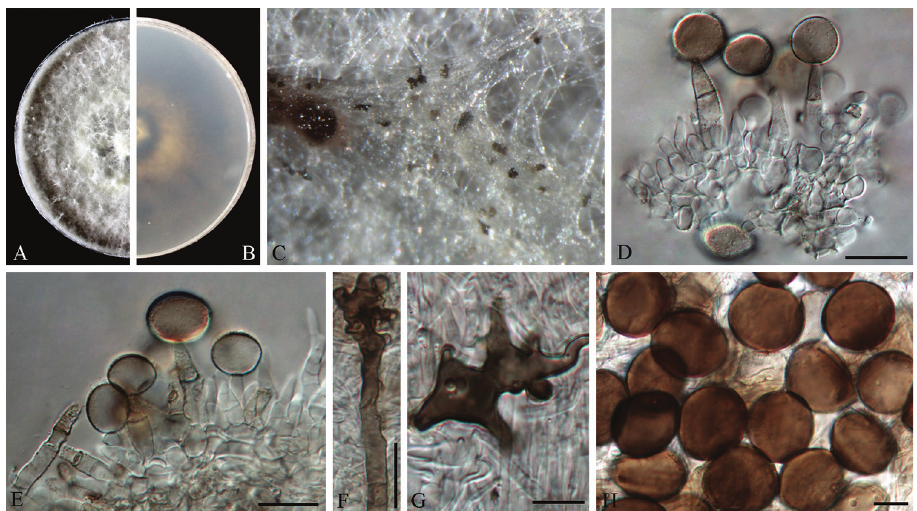
Figure 9. Arthrinium pseudoparenchymaticum (from ex-holotype strain CGMCC 3.18336) A–B 8 d old cultures on PDA C Colony on MEA producing conidia masses D–E Conidiogenous cells giving rise to conidia F–G Dentate conidia H Globose conidia. Scale bars = 10 µm. Arthrinium subroseum M. Wang & L. Cai, sp. nov. MycoBank: MB824913 Figure 10 Type. CHINA, Jiangxi Province, on bamboo, 1 Jul. 2016, J.E. Huang, (holotype: HMAS 247190; culture ex-type: CGMCC3.18337 = LC7292). Etymology. Named after the colour of colony on PDA,